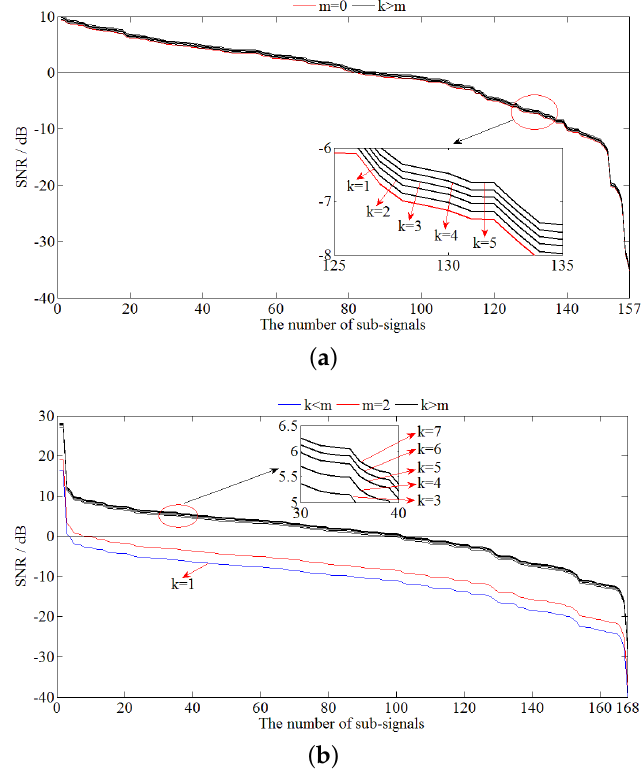
Figure 7. The signal to noise ration (SNR) sequence S k of normal and abnormal acoustic signals varies with the number k of abnormal sub-signals. ( a ) Normal acoustic signal: the actual number of abnormal sub-signals is m = 0. ( b ) Abnormal acoustic signal: the actual number of abnormal sub-signals is m =